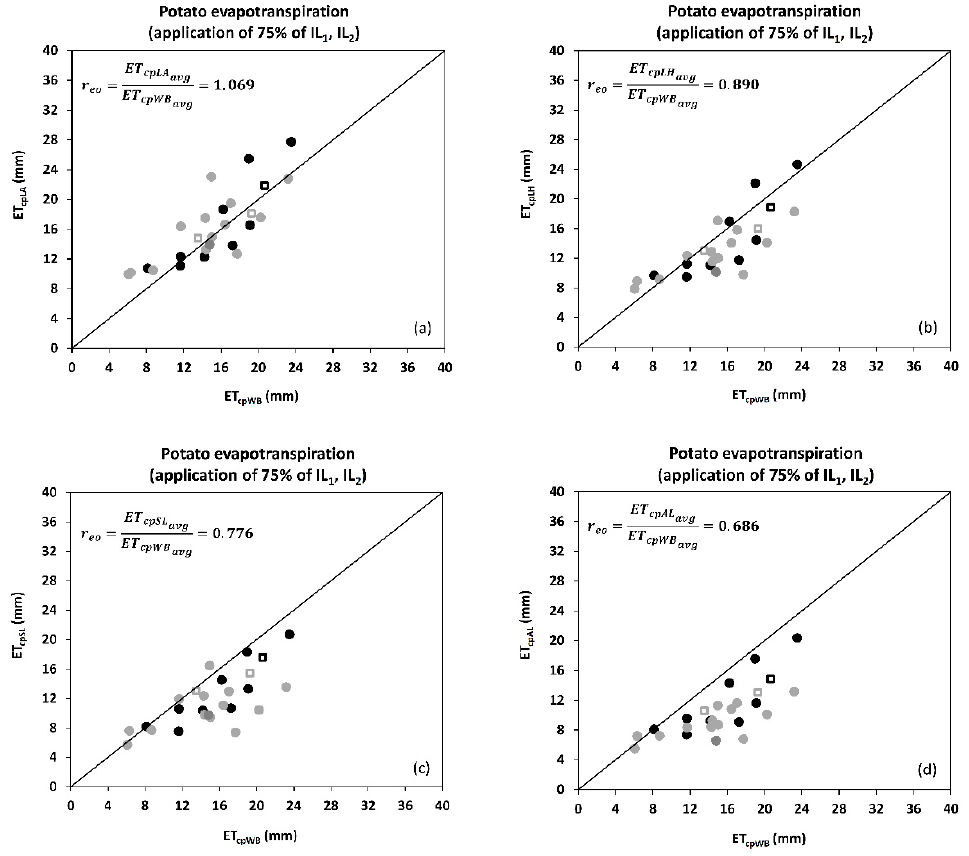
Figure 7. Comparison between potato evapotranspiration estimated by the water balance ( ET cpWP ) and Penman-Monteith ( ET cp ) methods using four canopy resistances approaches for the application of 75% of IL 1 (IL 2 ) in both seasons. LA and LH [63], SL [62] and AL [28] corresponding to the canopy resistance ( r c ) model at each ET cp approaches used in this study. ( a ), ( b ), ( c ), and ( d ) represent to LA, LH, SL, and AL, rspectively. Closed circles and open squares of black color correspond to the 2018/2019 season, whereas closed circles and open squares of gray color correspond to the 2019/2020 season. Square and circle points represent values of ET when LAI < 2 and LAI > 2, respectively. Each point compares the sum of ET among consecutive irrigation events.